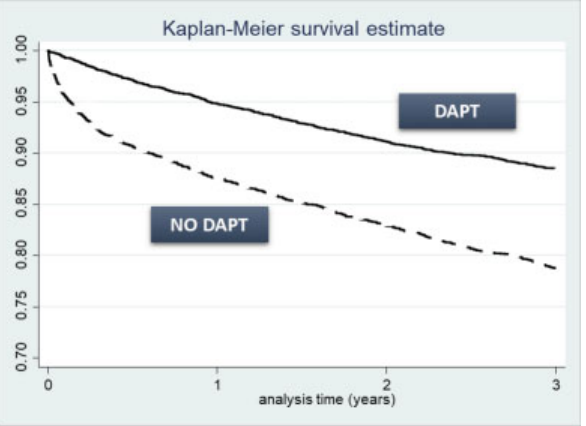
Fig. 2 Mortality at 36 months of follow-up (Kaplan – Meier). NO DAPT: N ¼ 3,540, no. of events ¼ 749 (21.2%); survivals after 3 years ¼ 2,791 (78.8%); DAPT: N ¼ 5,027, no. of events ¼ 580 (11.6%); survivals after 3 years ¼ 4,447 (88.4%). LHUs of Frosinone and Grosseto were excluded because data on deaths were not